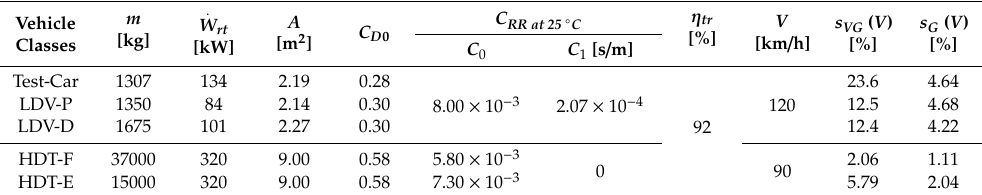
Table 1. Major specifications of the vehicles studied.